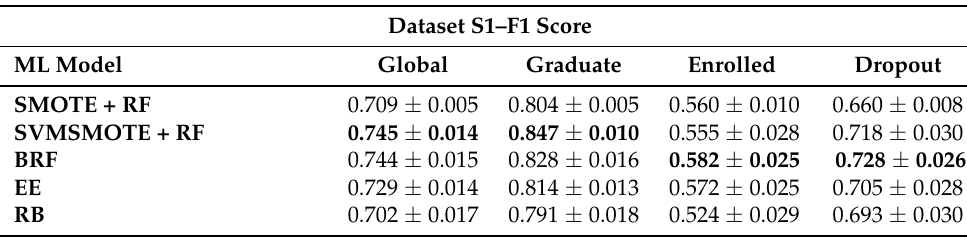
Table 7. F1 score evaluation for each class for each learning model built with information at the end of first semester. Values represent mean and standard deviation.